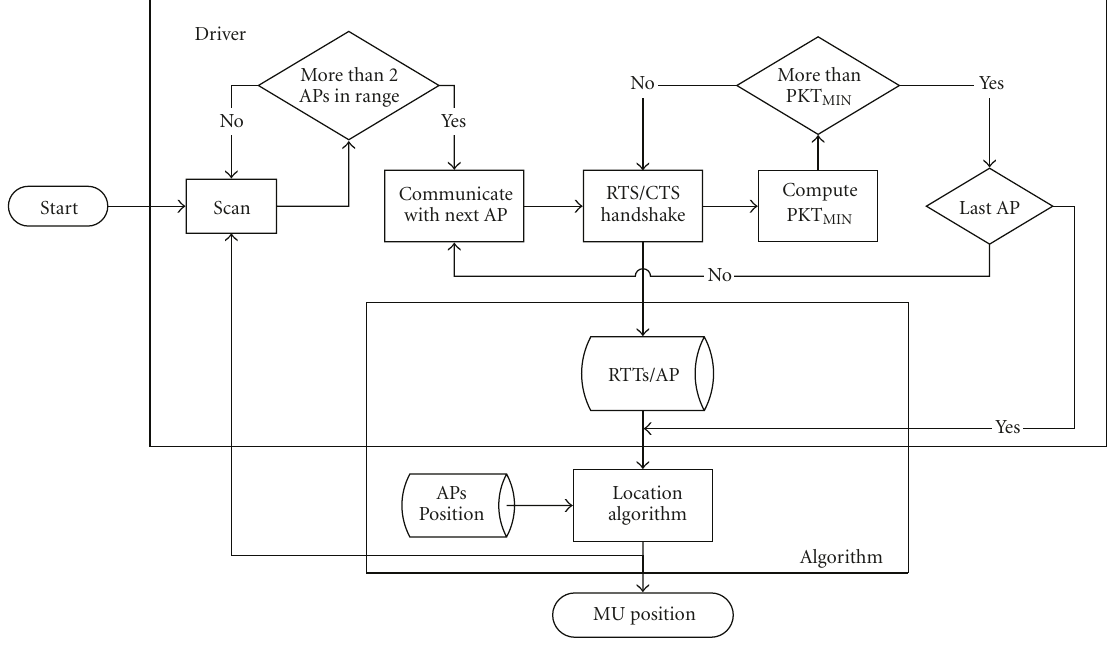
Figure 1: Flowchart of the system